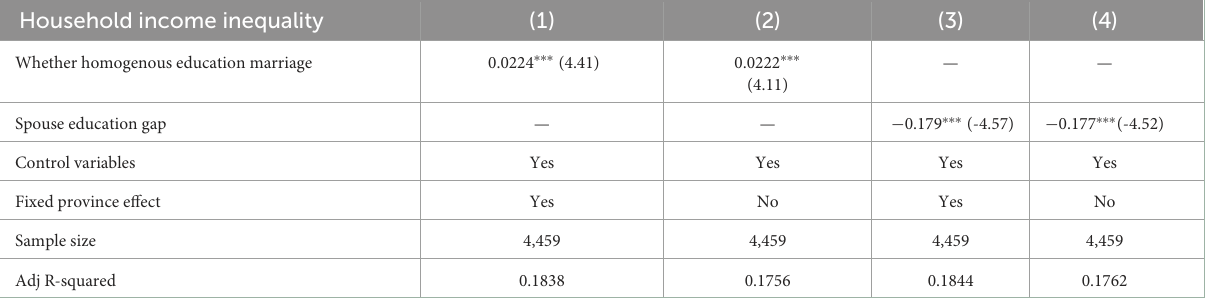
TABLE 4 OLS regression results of the educational structure of marriage on the relative deprivation of family per capita